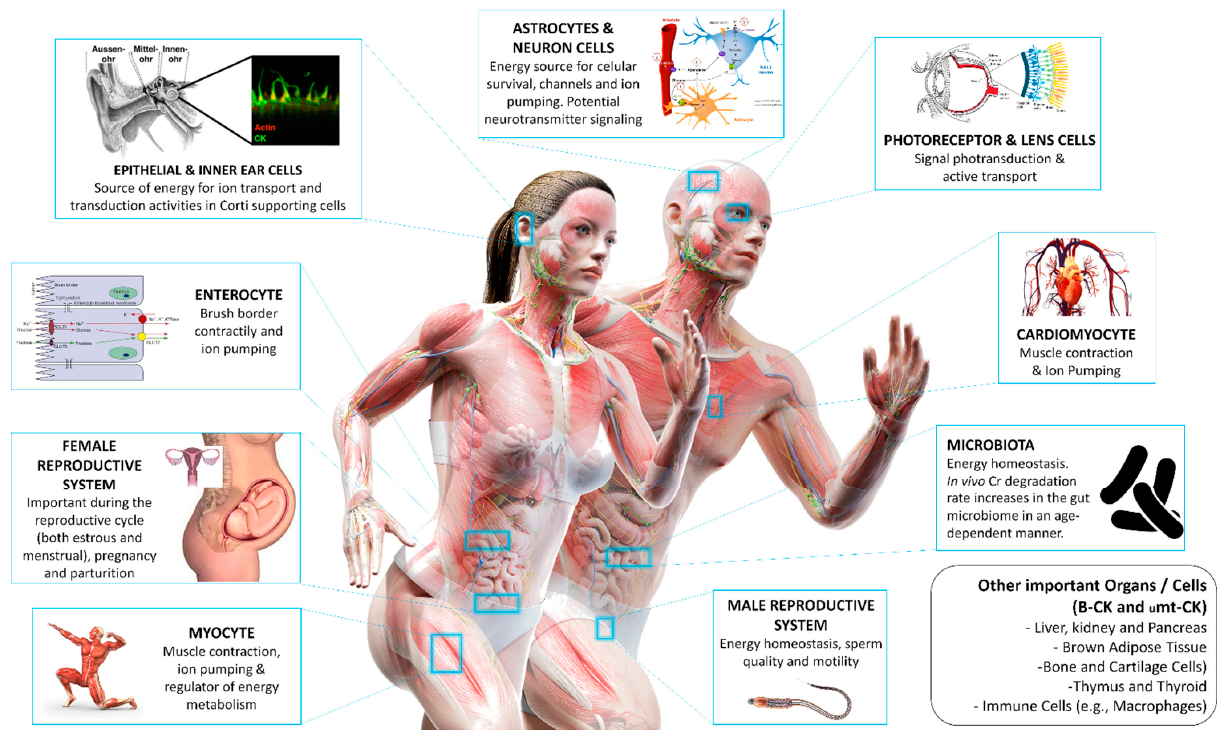
Figure 4. Importance of Cr metabolism in whole-body physiology. The CK/PCr system is essential for the chemo-mechanical energy transduction of cells/tissues with high, fluctuant, and constant energy demands. Source: designed by the authors (D.A.B.) using an anatomy template developed by 3dMediSphere (https://www.turbosquid.com/), licensed 3D